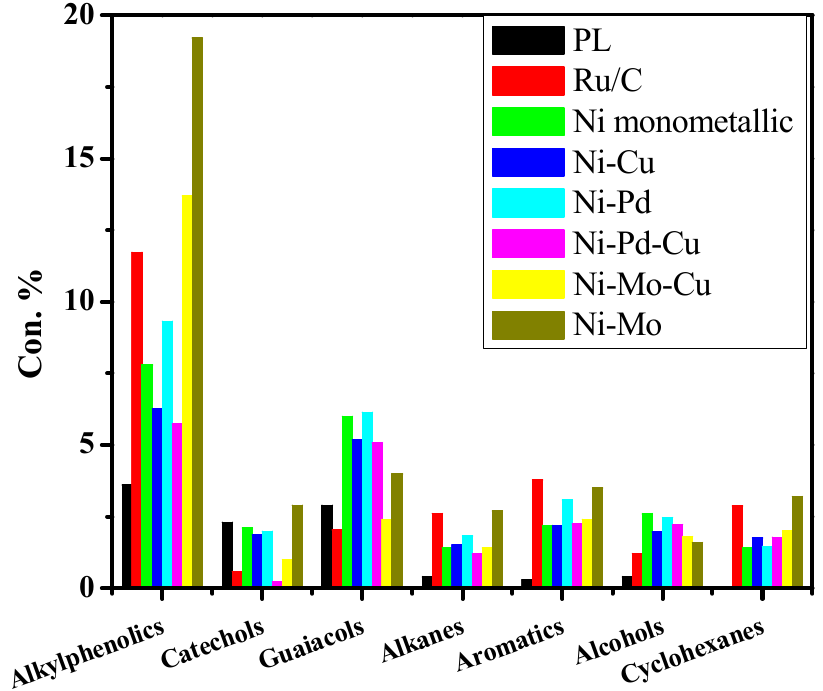
Figure 7. GC × GC analysis of PL and hydrogenated oils.